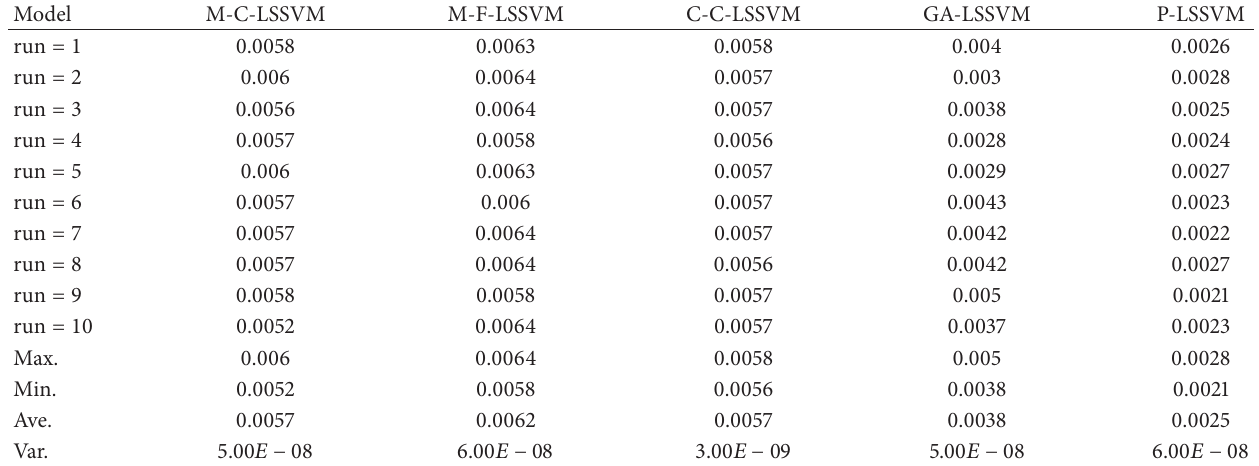
Table 12: Five models predicted error based on RMSE for interphone band.